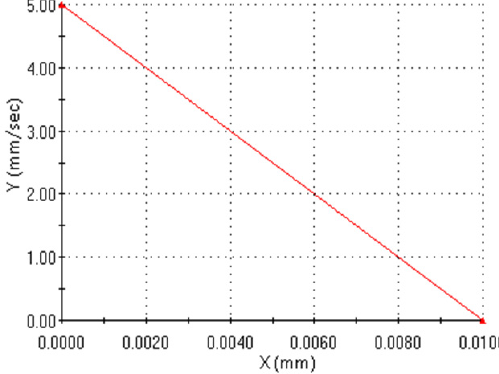
Figure 13. The dependence of the piston speed on the clearance